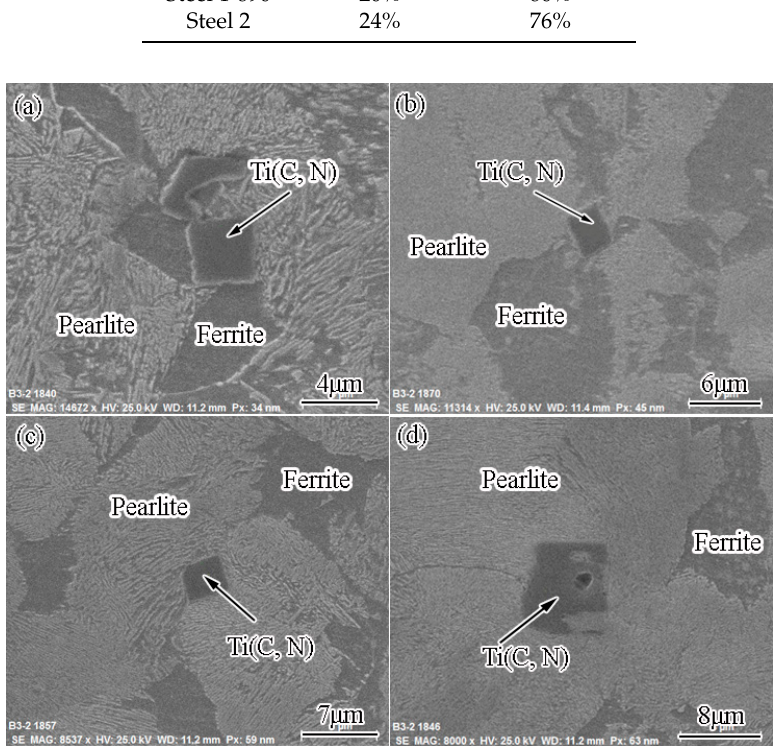
Figure 7. Coarse Ti(C, N) particles located in ferrite ( a , b ) and pearlite ( c , d ) in steel 1.